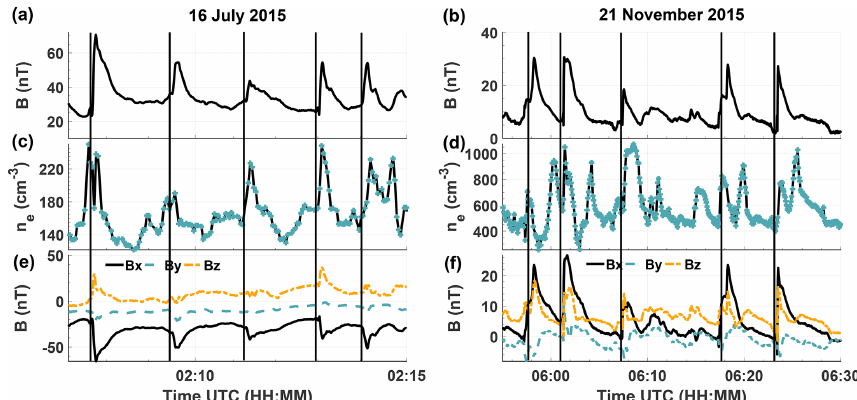
Figure 1. Magnetic field magnitude (a, b) , electron density (c, d) and magnetic field components (e, f) , with multiple occurrences of concurrent magnetic field and density enhancements on 16 July and 21 November